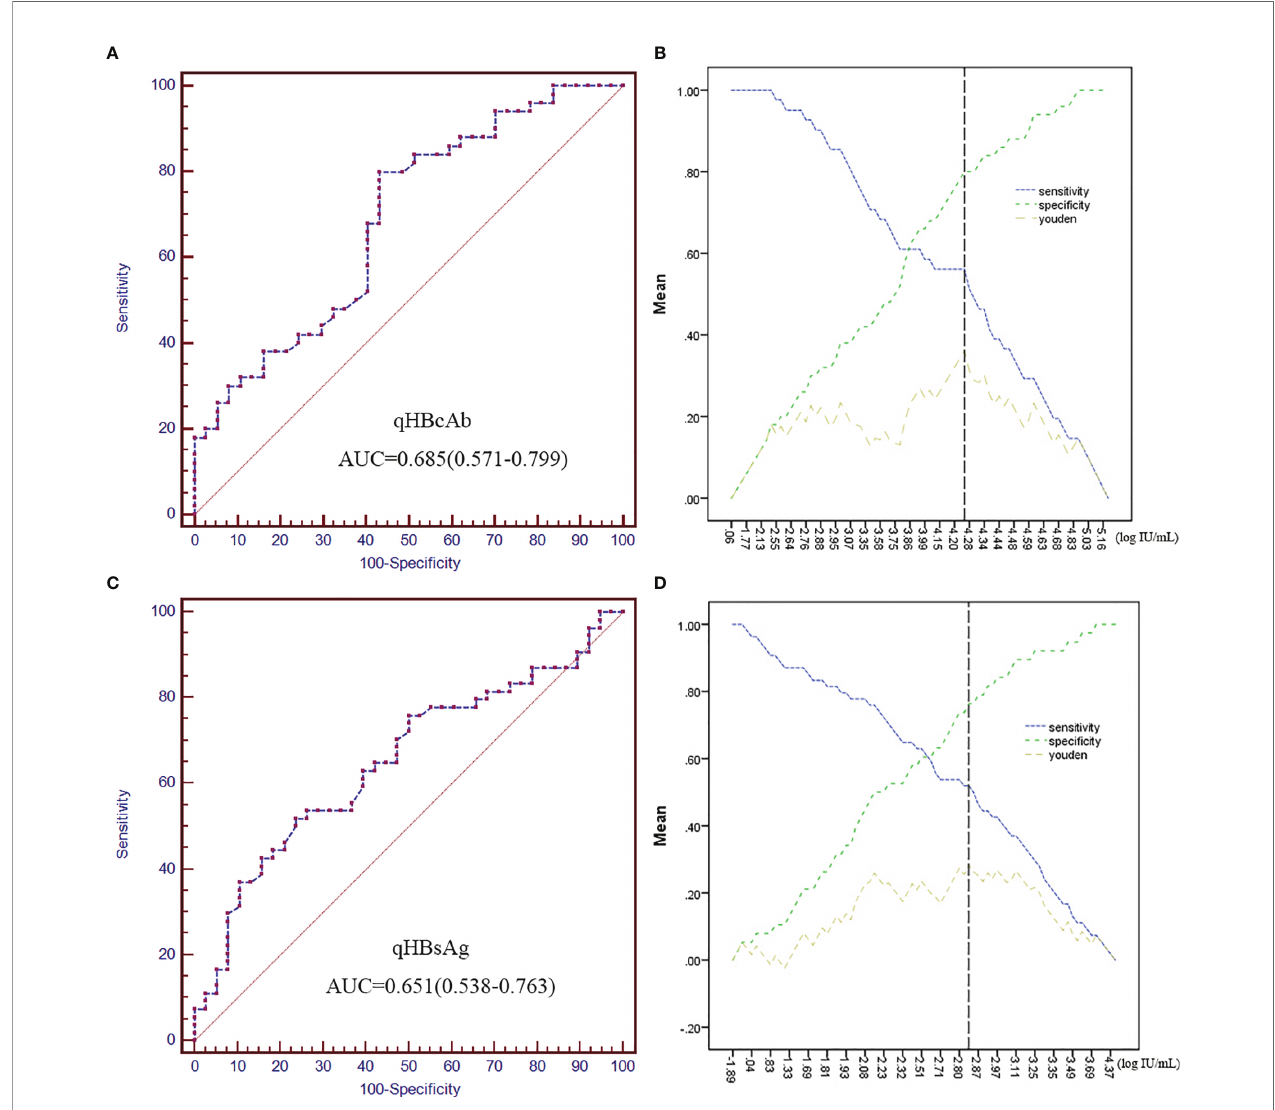
FIGURE 2 | QHBcAb and qHBsAg as predictors of HBsAg recurrence. (A, C) . Receiver operating characteristic (ROC) analyses of qHBcAb and qHBsAg as predictors of HBsAg recurrence at baseline. (B, D) . Curves of the speci fi city, sensitivity and Youden index for qHBcAb and qHBsAg. The position of the black vertical dotted line shows the maximum Youden index that was used to predict HBsAg